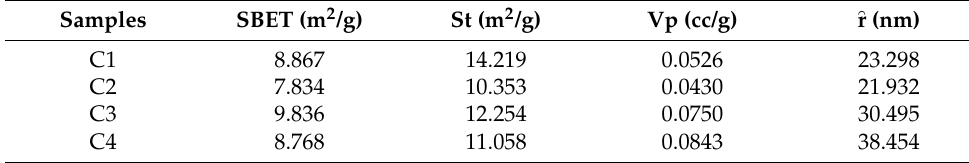
Figure 7. Transmission electron micrograph (TEM) images and particle size distribution of the C1 , C2 , C3 , and C4 samples. Table 5. Surface properties of the C1, C2, C3, and C4 samples.